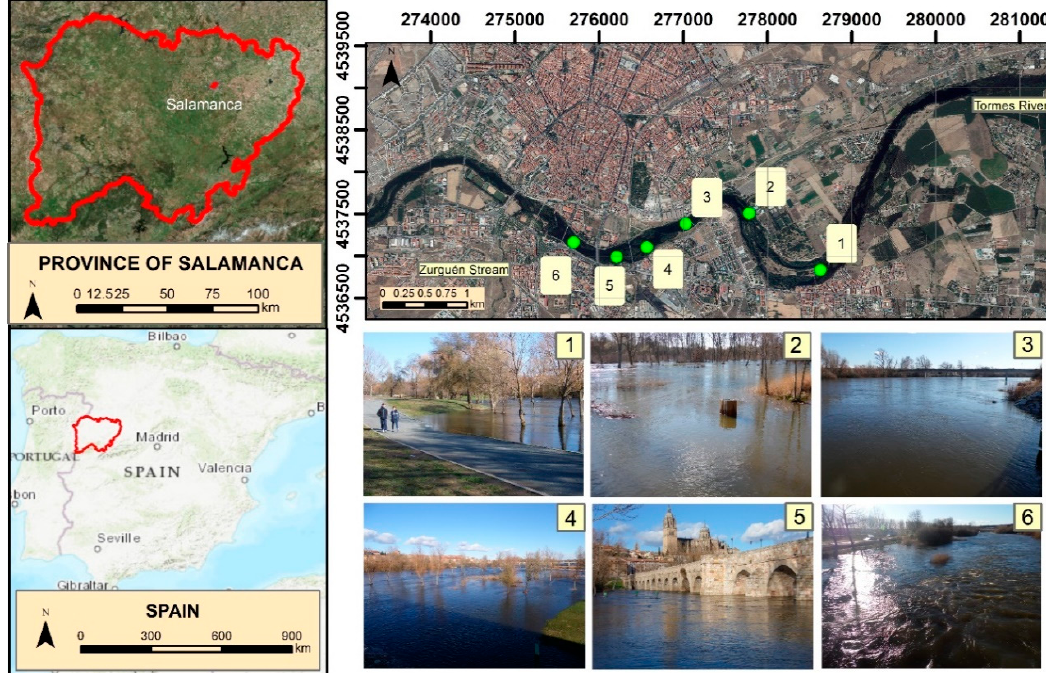
Figure 1. Study area and Tormes River in: (1) Fluvial island, in Santa Marta de Tormes; (2) “La Aldehuela”, in Cabrerizos; (3) Next to the water treatment plant of Salamanca; (4) Upstream of the Roman bridge; (5) Close to Roman Bridge and the Cathedrals; (6) Beside the hospital and the “Salas Bajas” sport center.